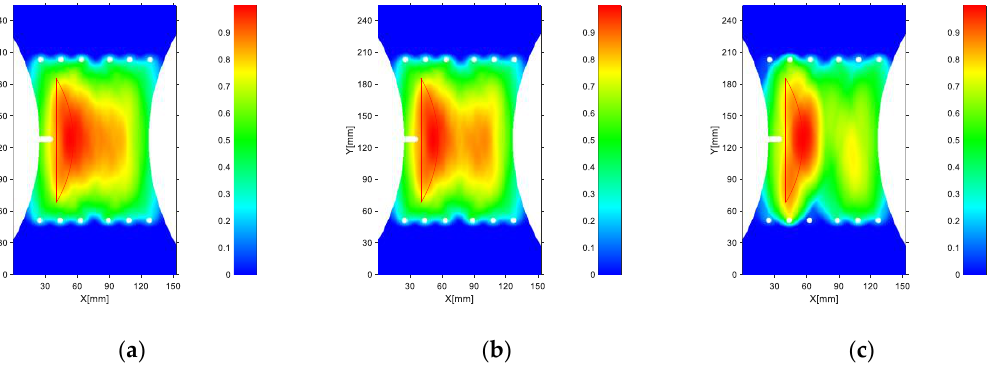
Figure 12. Images for different damage factors at 20,000 fatigue cycles: ( a ) energy damage factor; ( b ) cross-correlation damage factor; ( c ) sparse representation damage factor.